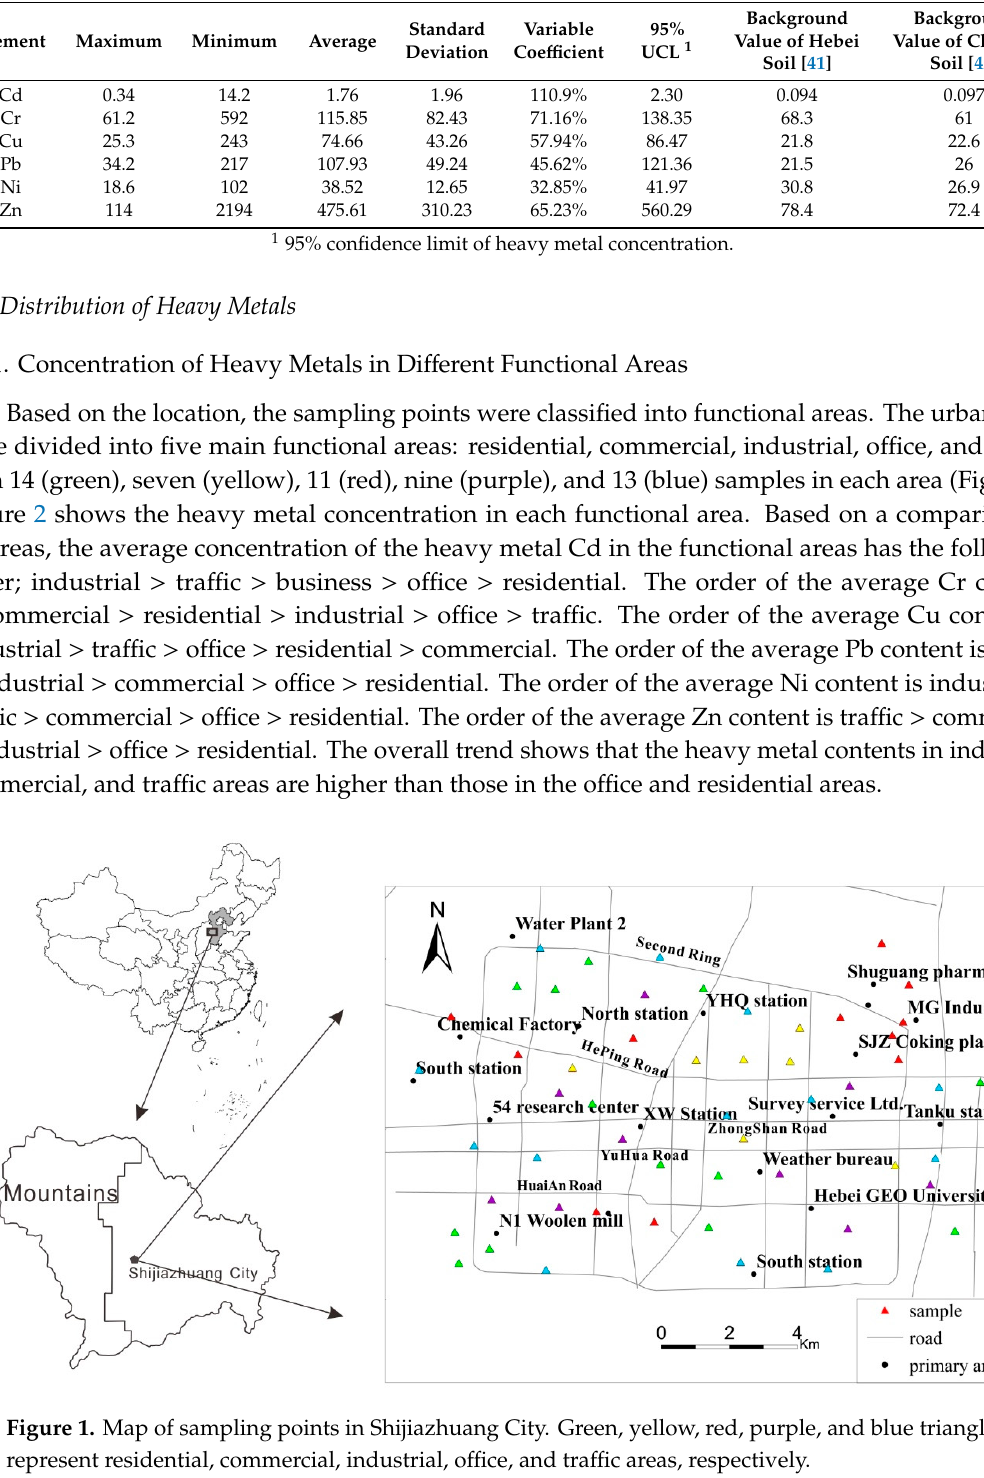
Table 1. Statistical values of heavy metal concentrations in urban atmospheric deposition (mg / kg).